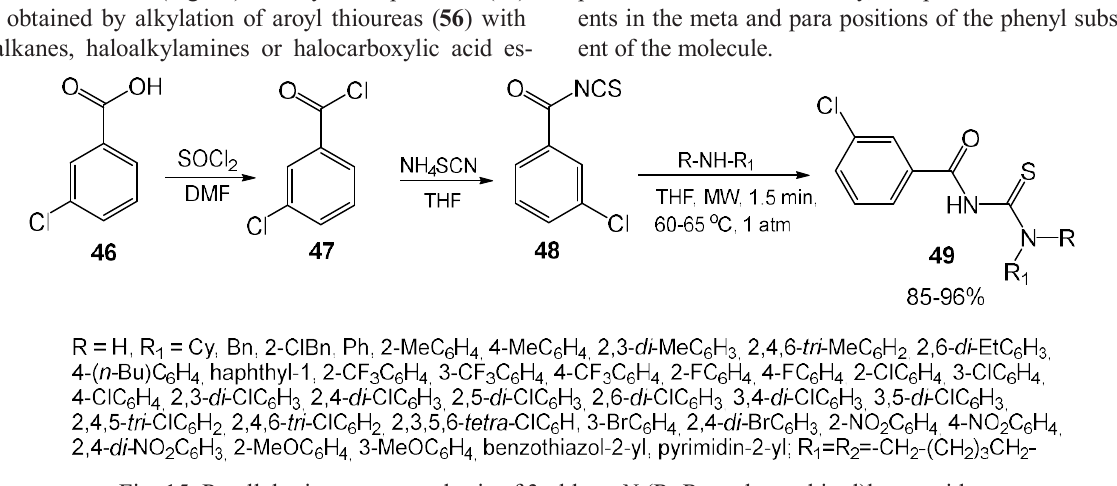
Fig. 15. Parallel microwave synthesis of 3-chloro- N- (R, R